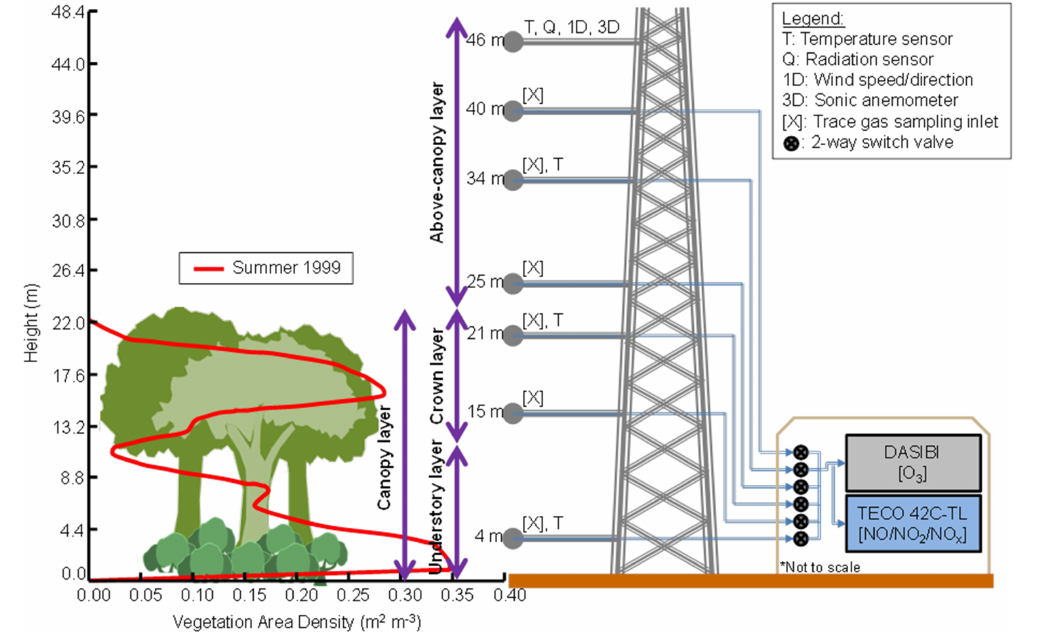
Fig. 1. The forest architecture as vegetation area density profile at UMBS in the summer of 1999, modified from Fig. 2a of Schmid et al. (2003), and a cartoon depiction of the AmeriFlux tower with sensor locations drawn to scale but gas analyzers and housing unit not drawn to scale.